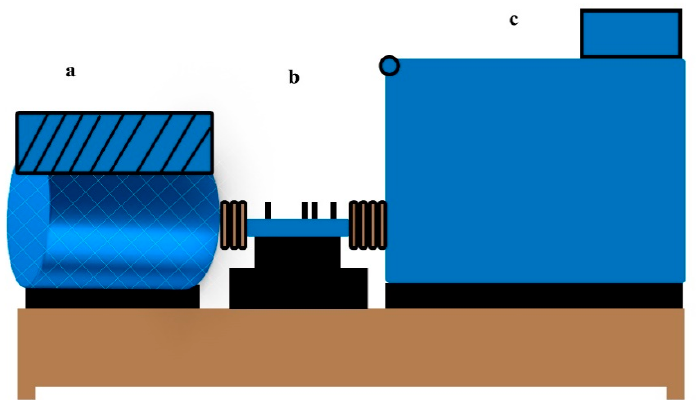
Figure 4. An illustration of Case Western Reserve University bearing test rig. Where (a) two HP motors, (b) a torque transducer/encoder, (c) dynamometer and control electronics.